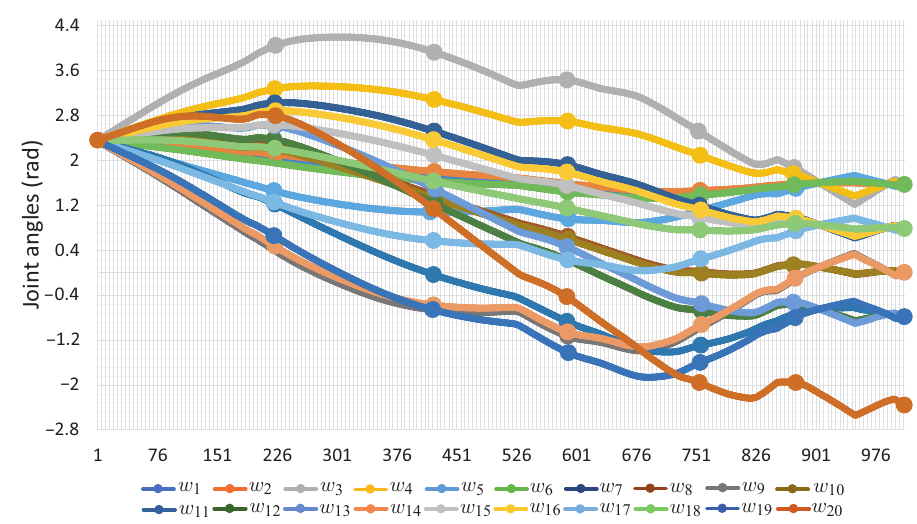
Figure 20. Joint w -angle motion for Case Study 3.